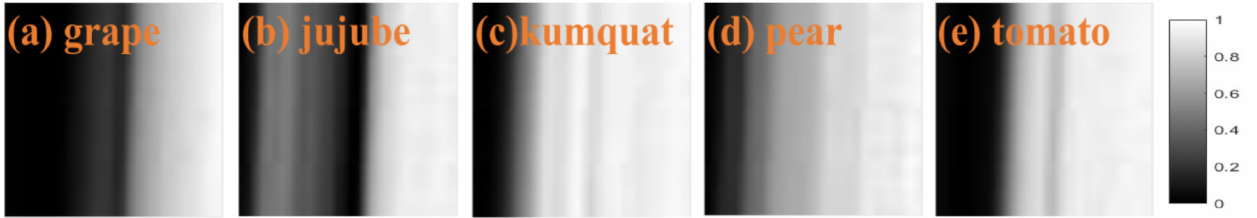
Figure 5. 2D spectral data samples.